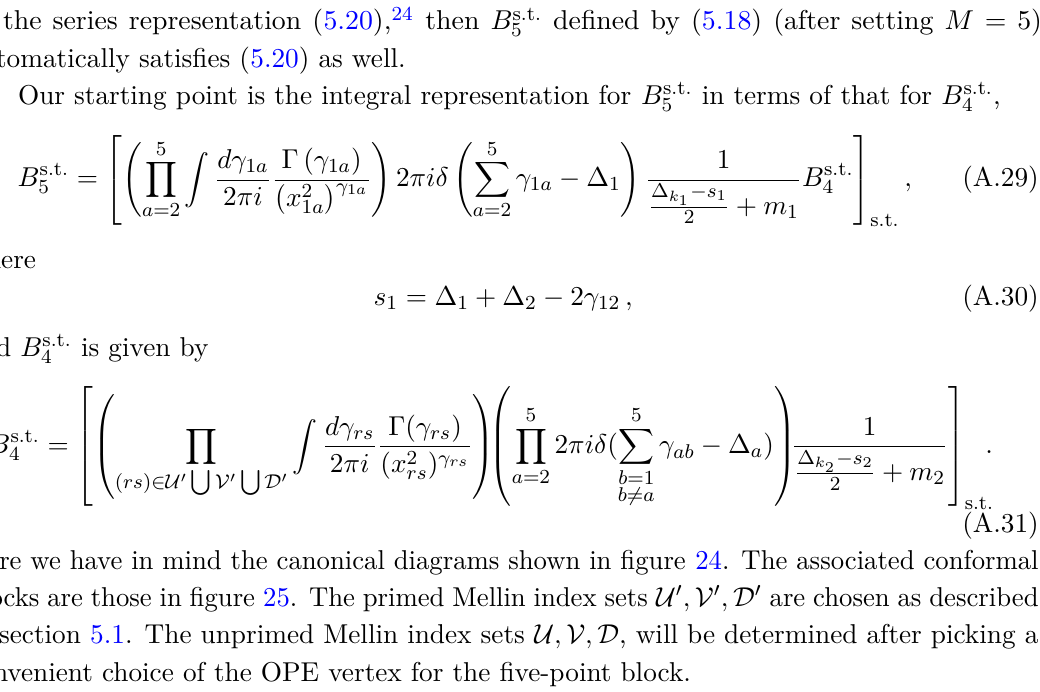
which reproduces the well-known result from the literature [11], 23 consistent with the Feynman rules of section